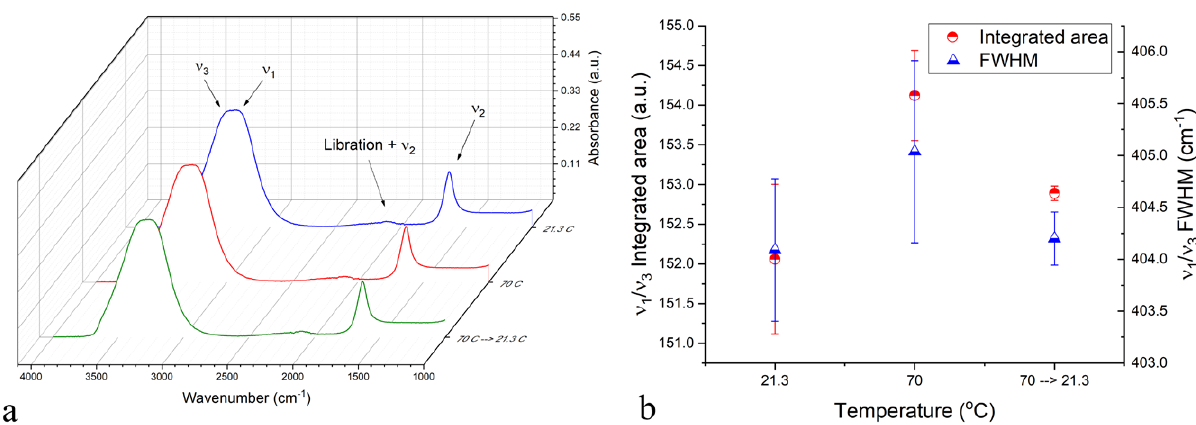
Figure 5. FTIR spectra of DI water droplets maintained at room temperature (21.3 o C), heated to 70 o C (70 o C) and cooled down to room temperature after being heated to 70 o C (70 o C → 21.3 o C) (a), along with the integrated areas and FWHM of the n 1 / n 3 OH stretching mode in three different waters measured after the baseline removal procedure (b). Data points in (b) represent averages of three independent measurements, while error bars represent standard deviations of the